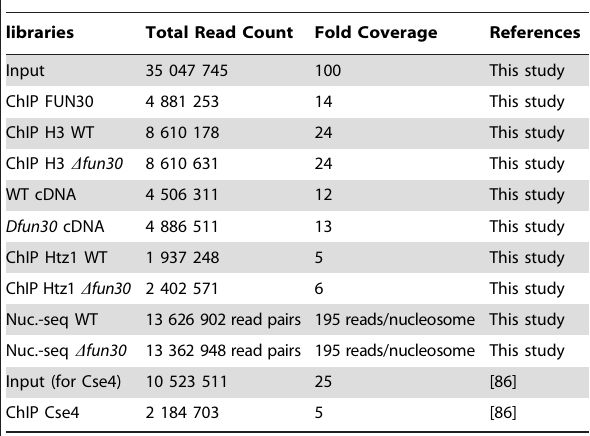
Table 4. Summary of sequence